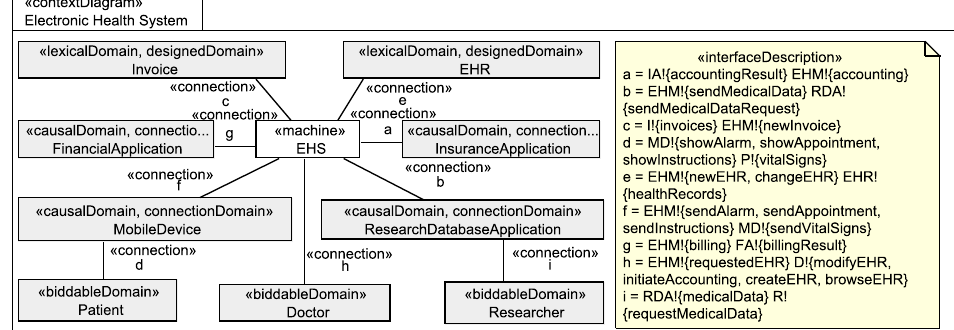
Figure 1. Context diagram for the EHS scenario.